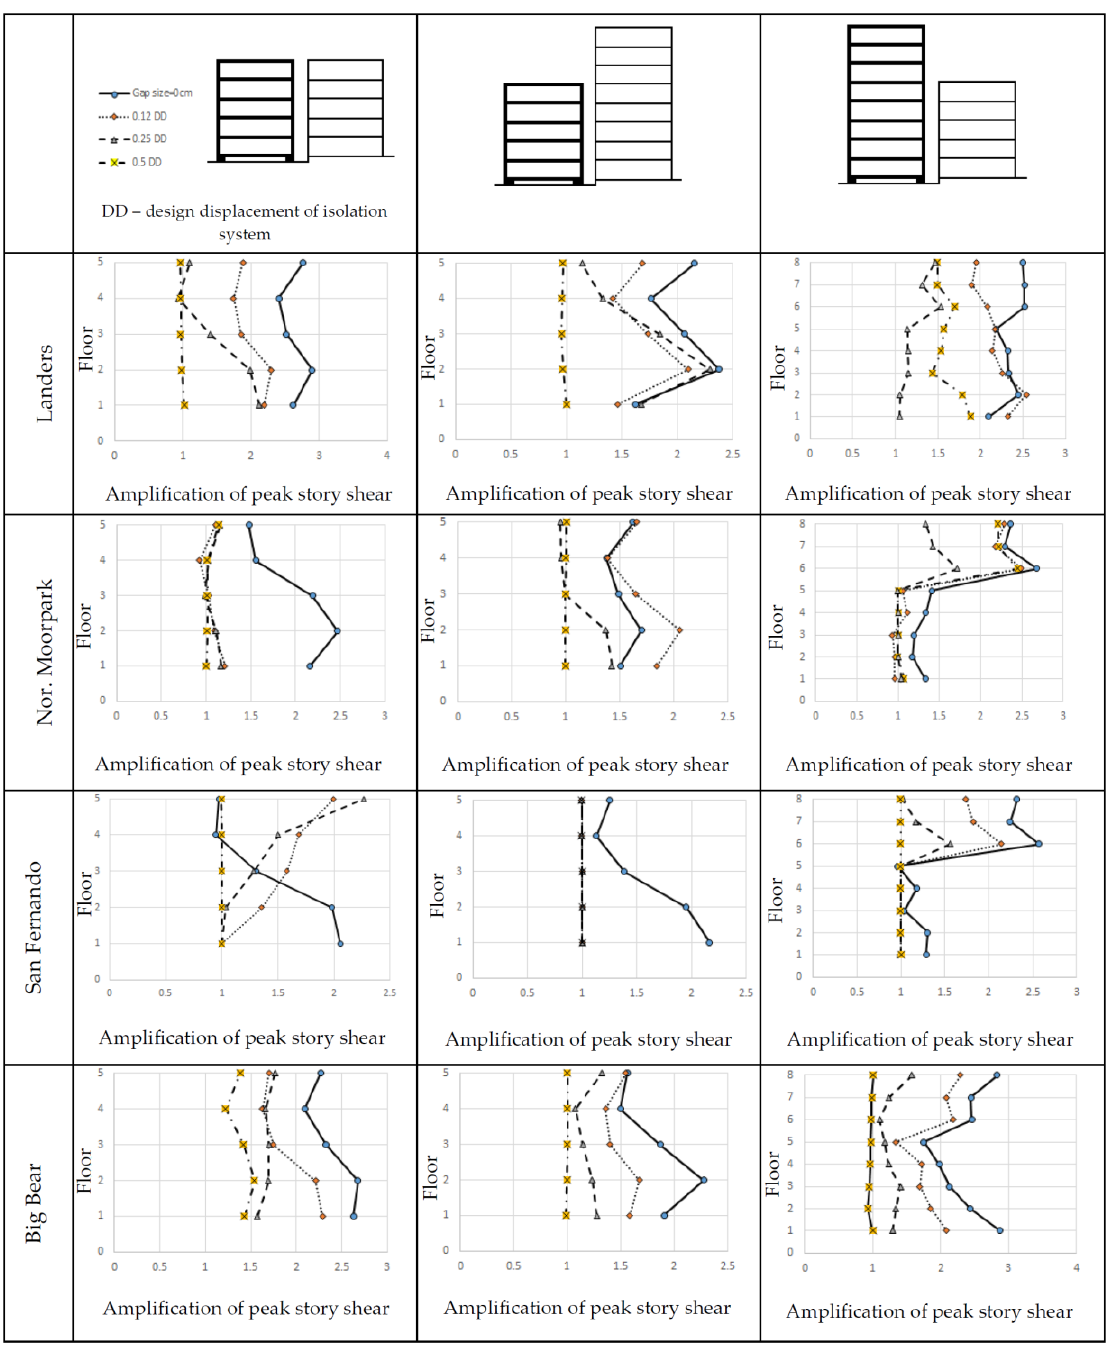
Figure 8. Story shear amplification factors due to pounding for different gap sizes and various stories of the base-isolated building during the Landers, Northridge (station: Moorpark), San Fernando, and Big Bear earthquakes.